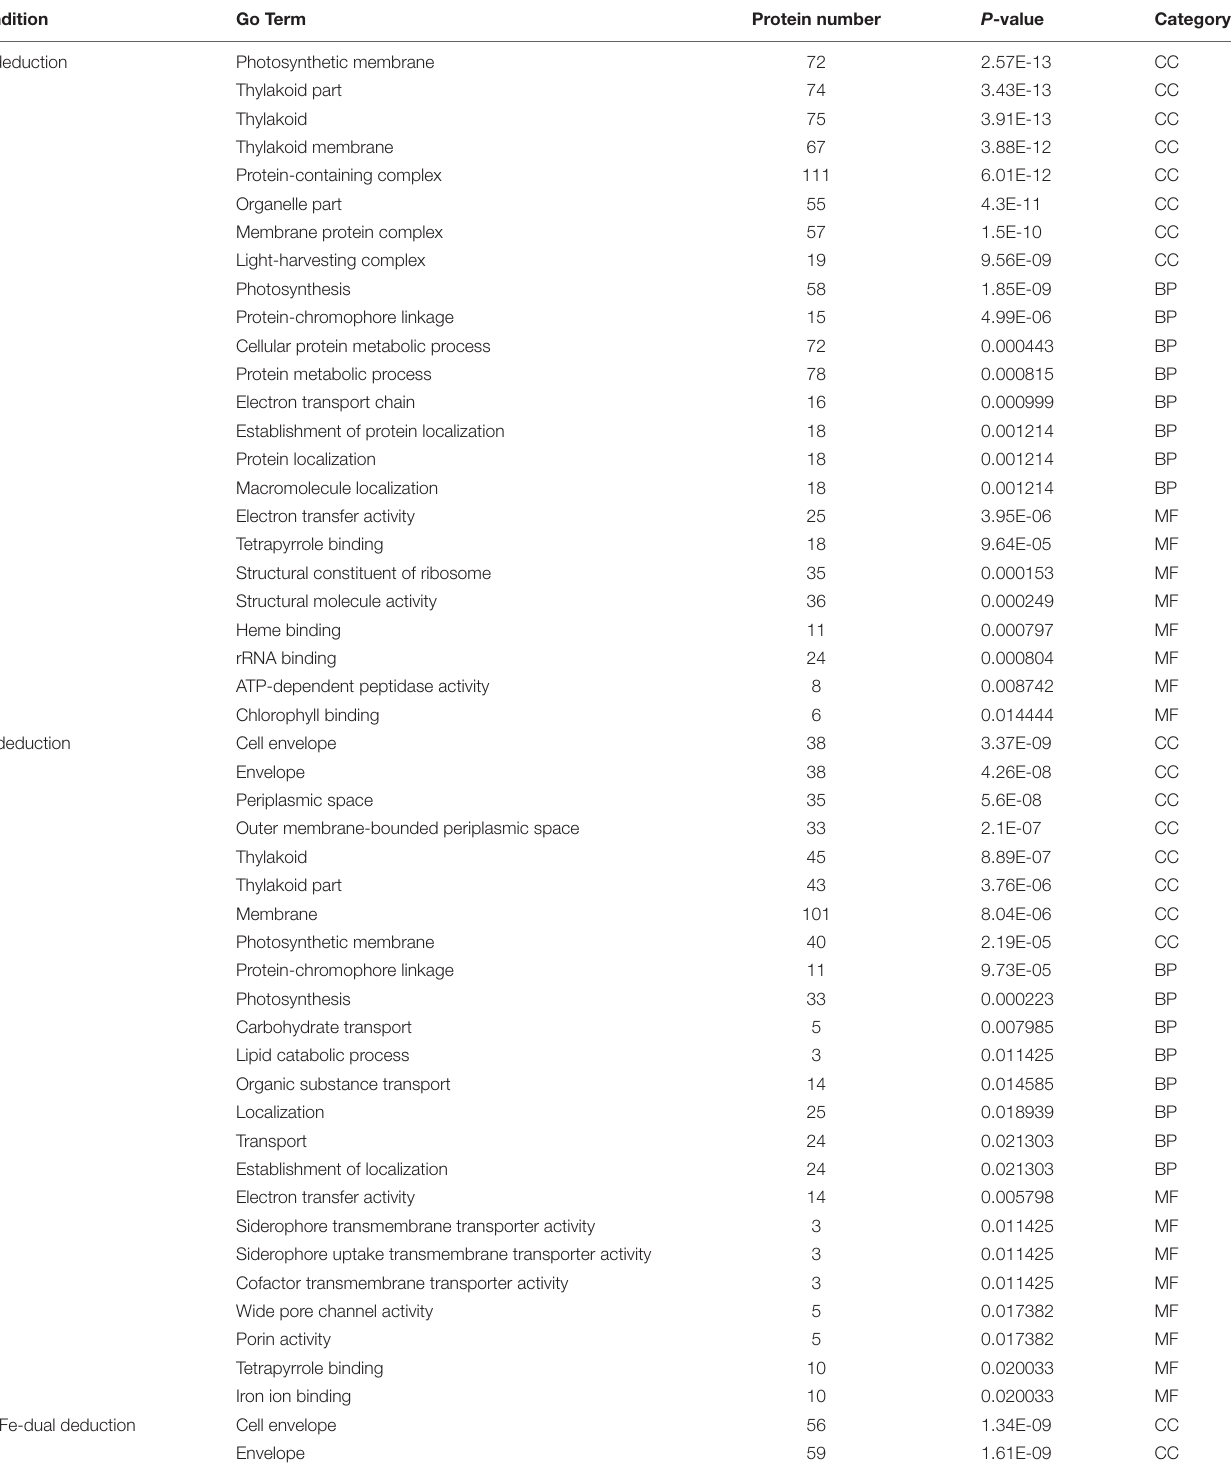
TABLE 1 | Enriched Gene Ontology (GO)